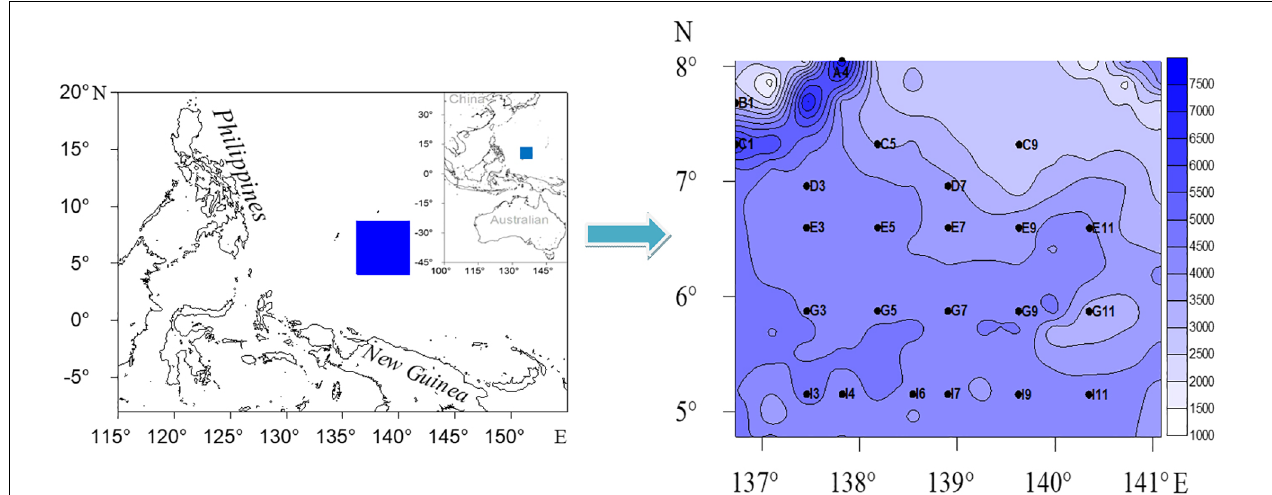
FIGURE 1 | Map of the adjacent areas to the Yap trench, Western Pacific Ocean, showing the sampling sites with fathom lines (Unit: m).